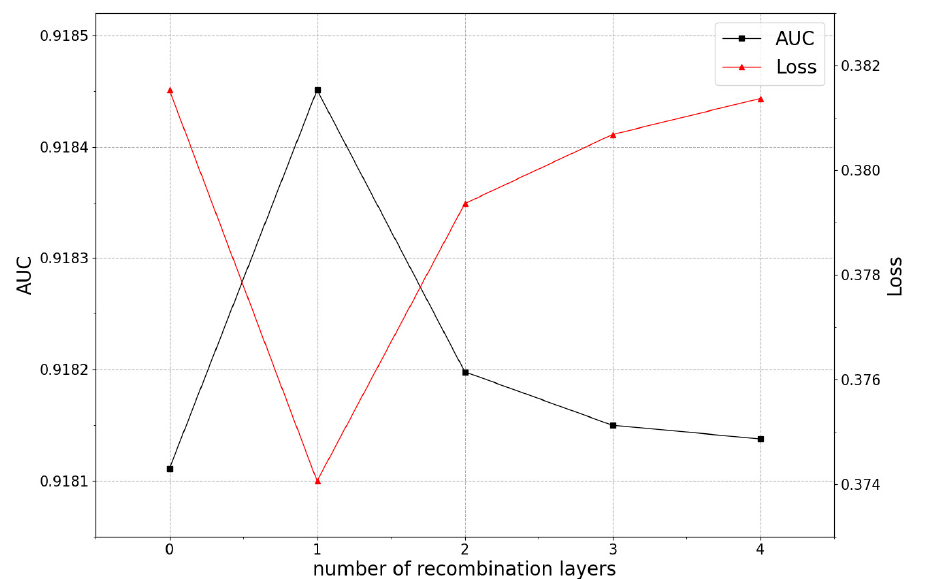
Figure 8. The impact of the number of recombination layers on model